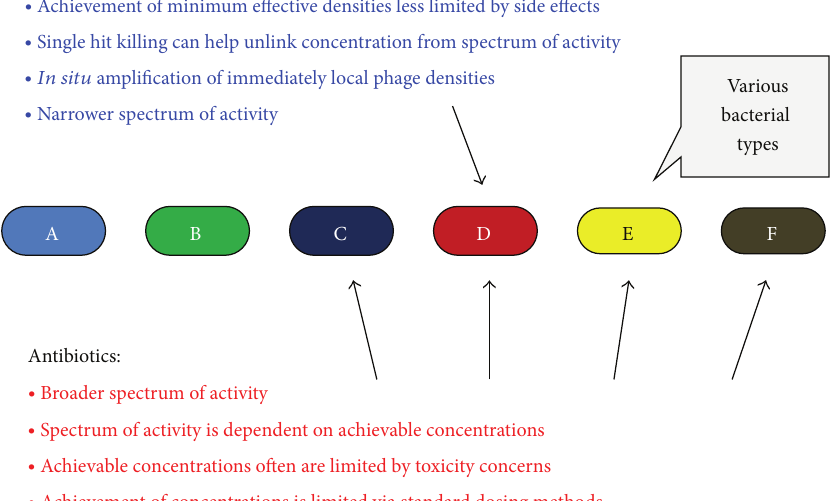
Figure 12: First-approximation comparison of bacteriophages and antibiotics in terms of their activity spectra in combination with various concentration and dosing issues. In short, phages tend to display narrower activity spectra but that activity can be less dependent on concentration issues, particularly given passive treatment, than the activity spectra displayed by small-molecule antibacterial